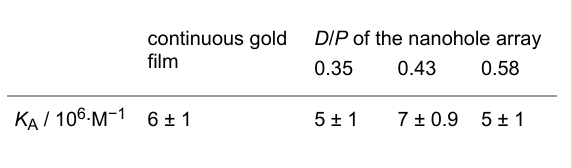
Table 2: Binding constants K A for rGO-modified nanohole arrays with D / P ratios 0.58, 0.43 and 0.35 compared to a continuous rGO-modi- fied gold film. Data were fitted with the Langmuir equation (Equation 1). Fitting parameters are shown in Table S3 (Supporting Information File 1).